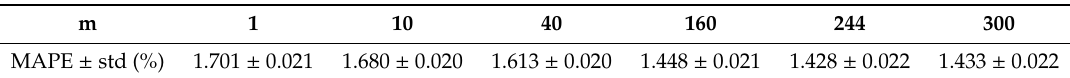
Table 7. Mean MAPE errors for all the weeks of 2019, using the ensemble of neural networks using di ff erent values of m.